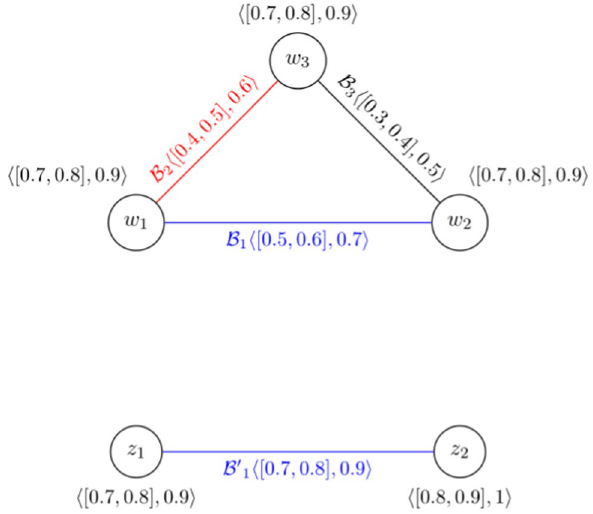
Fig. 7 The CFGS 𝔊 = G ∗ G � = ( 𝔄 , 𝔅 1 , 𝔅 2 , 𝔅 3